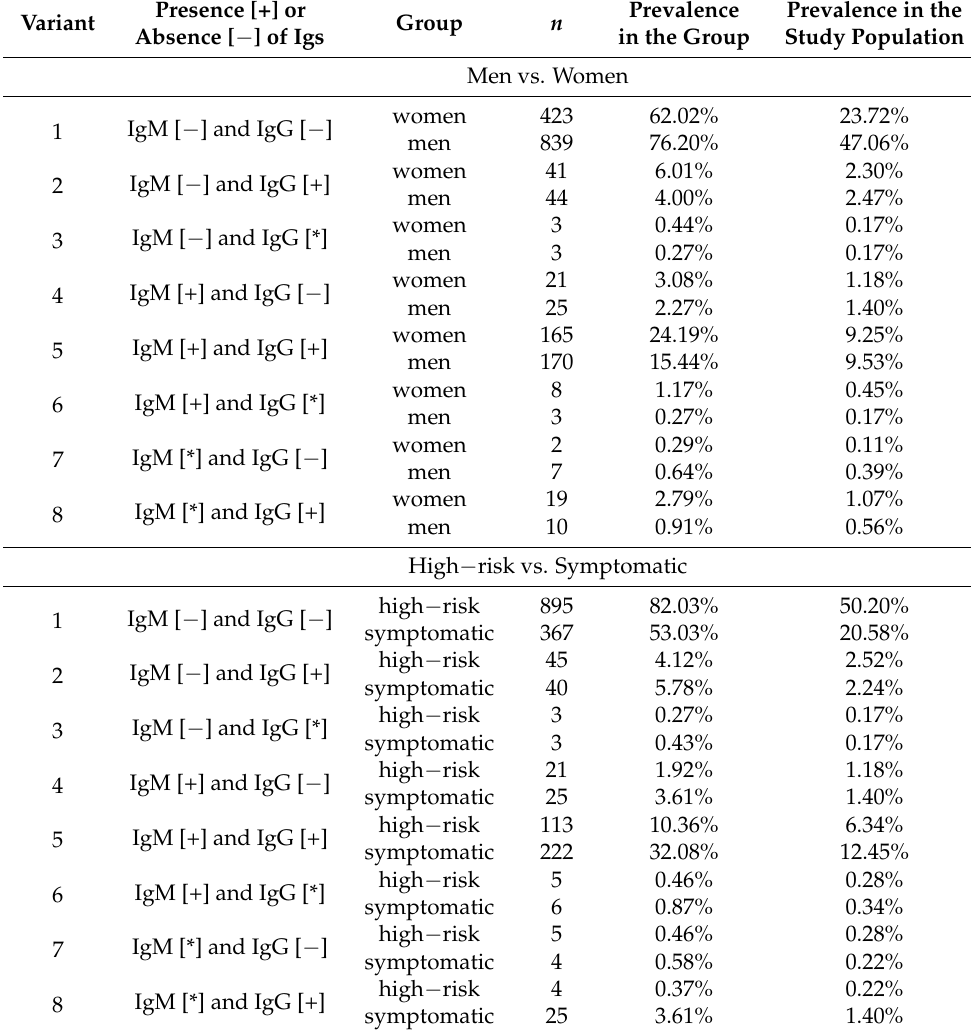
Table 2. Seropositivity rates for joint detection of IgG and IgM in persons of high-risk and symp- tomatic